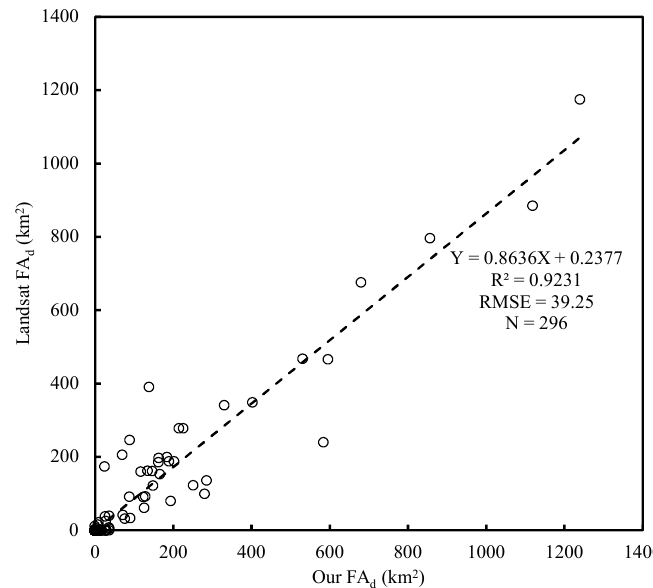
Figure 7. Scatter plot of our daily cyanobacteria bloom areas (FA d ) versus that of Landsat interpretation.